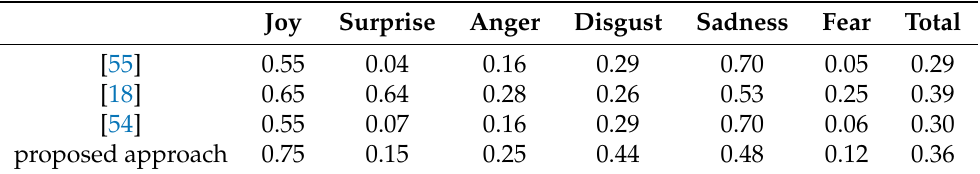
Comparison Per-class emotions accuracy of state-of-the-art methods with sponta- neous